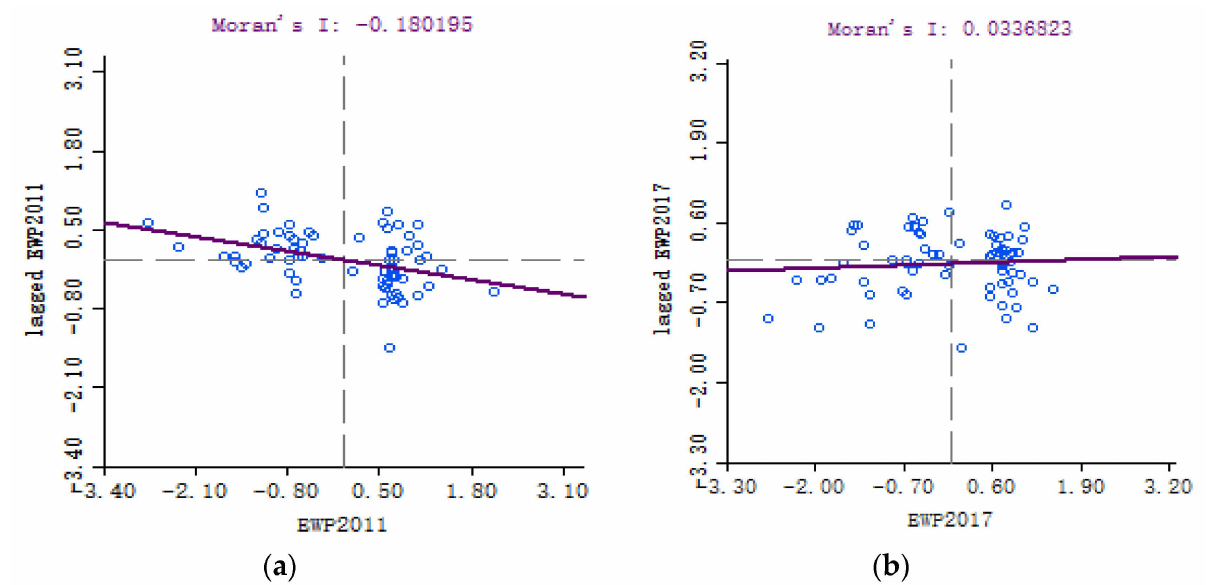
Figure 7. Moran scatter plot of the EWP in 2011 ( a ) and 2017 ( b ).